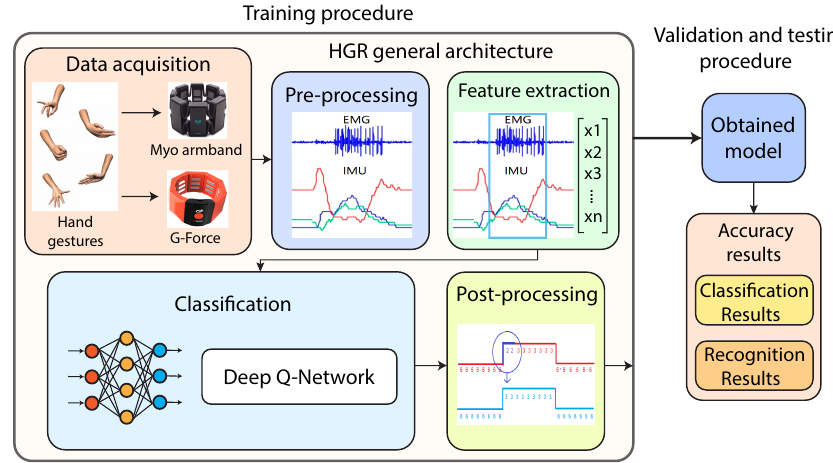
Figure 1. Hand gesture recognition method based on EMG-IMU and RL.